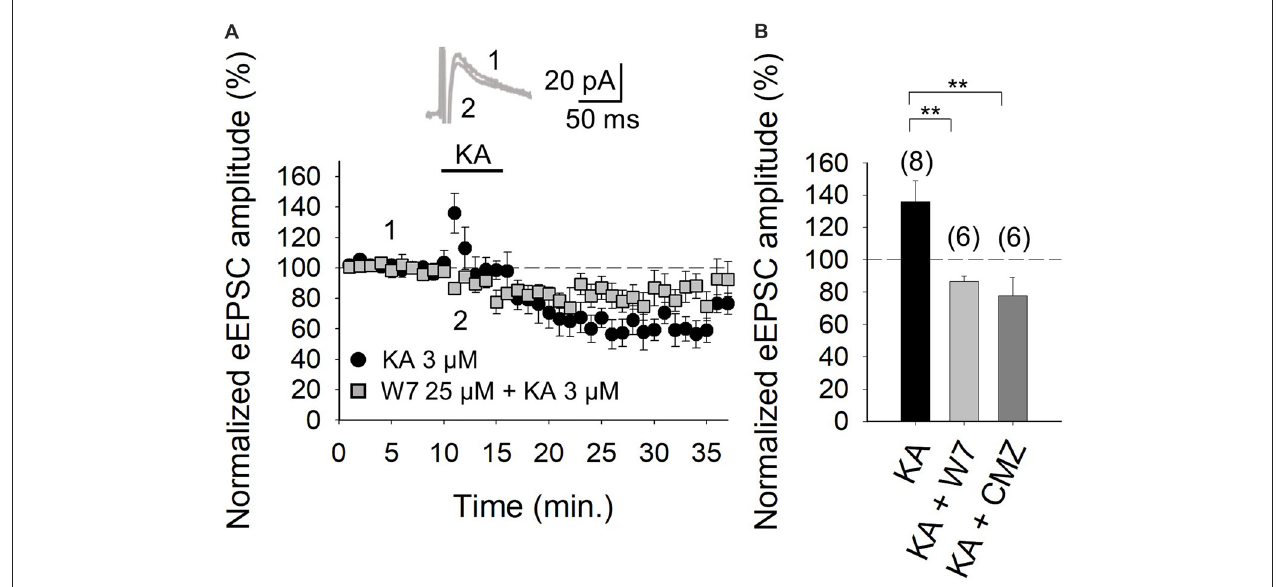
FIGURE 4 | Facilitation of glutamate release mediated by presynaptic KAR activation requires Ca 2 + -calmodulin at PF-PuC synapses. (A) Time-course of KA (3 µ M) effect on eEPSCs amplitude in control condition (circles) and in the slices treated with 25 µ M W-7 (squares). Inset show traces before and after 4 min KA perfusion from W-7 treated slices. (B) Quantification of modulation observed in (A) and in the presence of 1 µ M CMZ. The number of slices (from two to three mice) is indicated in parenthesis at the top of each bar. Results are expressed as means ± SEM ( ∗∗ P < 0.01, ANOVA